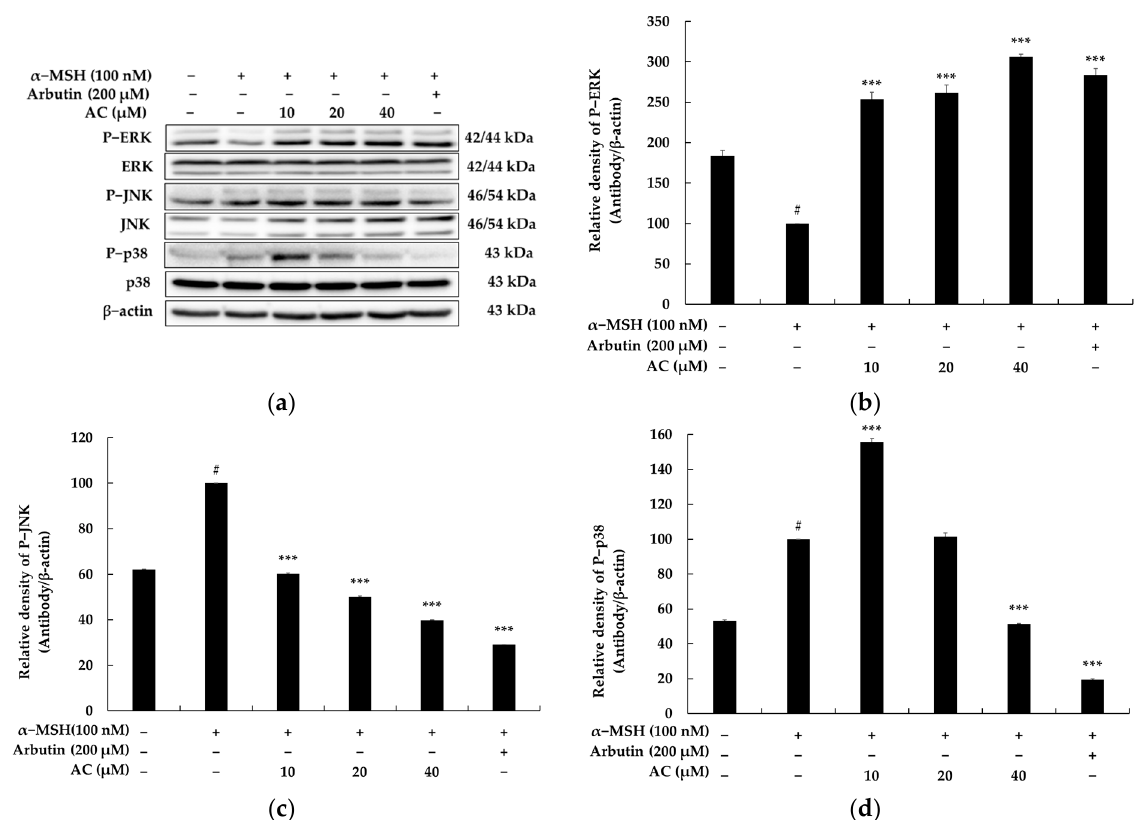
Figure 5. The e ff ect of acenocoumarol on MAPKs protein expression in α− MSH-stimulated B16F10 cells. The cells were treated with acenocoumarol (10, 20 and 40 μ M) for 4 h in the presence of α− MSH (100 nM). Western blotting results ( a ), P − ERK protein expression ( b ), P − JNK protein expression ( c ), P − p38 protein expression ( d ). α− MSH was used as the negative control and arbutin (200 μ M) was used as the positive control. We conducted three repeated measurements using Image J and present the results as mean ± SD. Statistical significance was expressed as follows: # p < 0.001 vs. unstimulated control group, *** p < 0.001 vs. α− MSH alone.